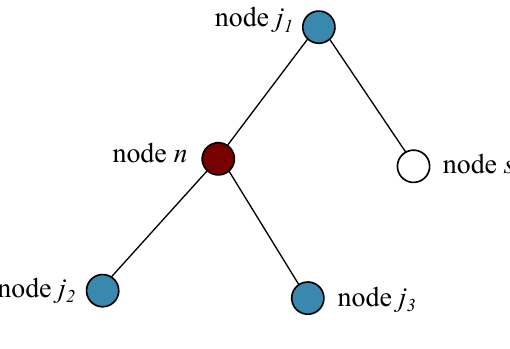
Figure 12. A case of privacy disclosure.